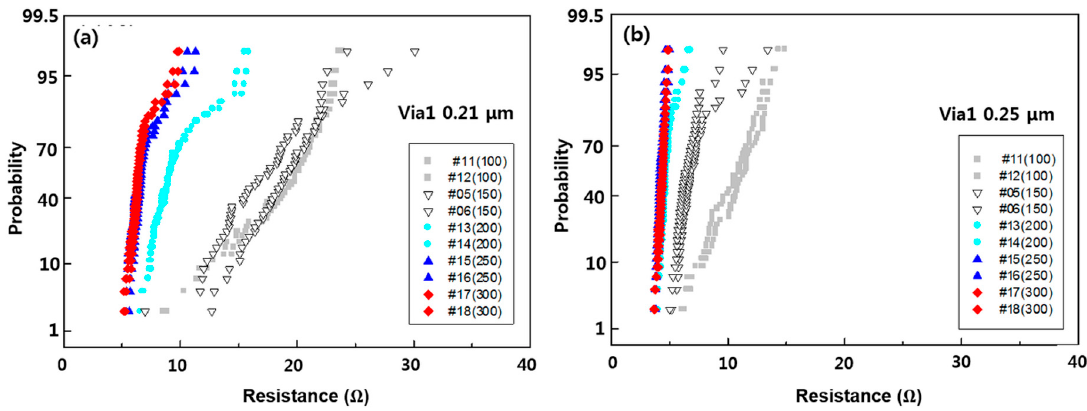
Figure 4. Via resistance according to IMP Ti thickness in minimum via size pattern ( a ) via 1 0.21 μ m, ( b ) via 1 0.25 μ m.